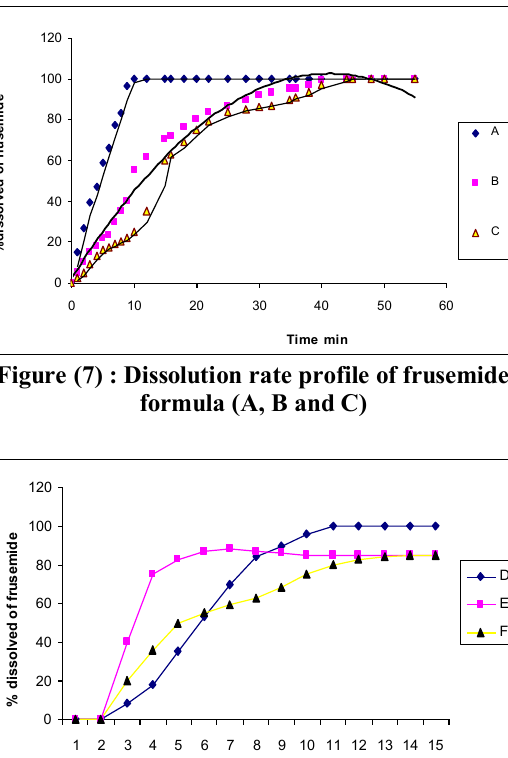
Figure (8) : Dissolution rate profile of frusomide formulas (D, E and F)